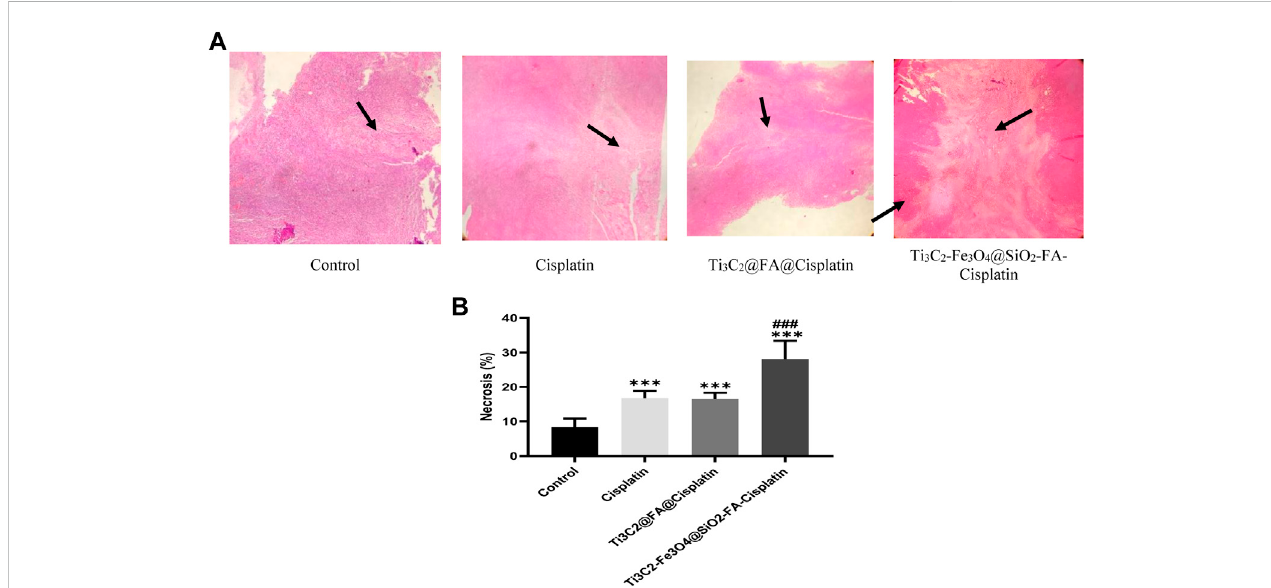
FIGURE 10 ThecombinationofTi 3 C 2 -Fe 3 O 4 @SiO 2 -FA-CisplatinpromotesnecrosisincervicalcancertumorscomparedtoTi 3 C 2 @FA@CisplatinandCisplatinalone. ThetumornecrosisisindicatedbyH&Estainingunderalightmicroscope (A) ;necrosisareasareindicatedwitharrows. (B) UsingtheimageJsoftware,quantify the necrotic area.